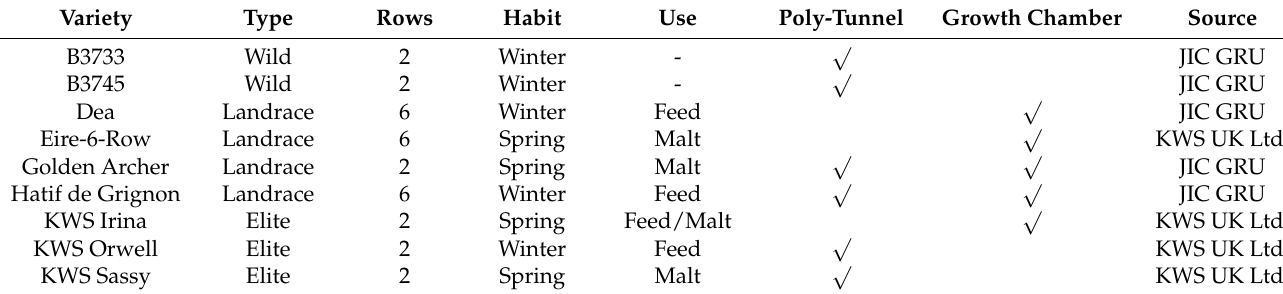
Table 1. List of elite, wild and landrace barleys, their key selection criteria, the experiments in which they were used and the source of the seed material. Selection criteria were the varietal type (wild, landrace or elite cultivars), the number of rows on the ear (2 or 6), the habit or vernalization requirement (winter or spring) and the typical end use of the variety (feed or malt). A Polytunnel and growth chamber were used to permit a degree of control over the environment in which the experiments were